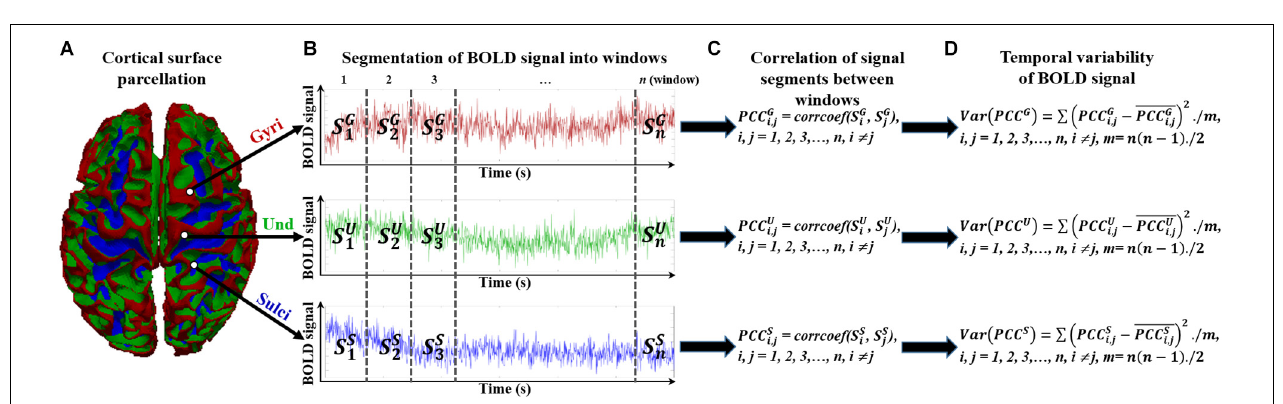
FIGURE 1 | Cortical surface parcellation of gyri, sulci, and undefined. (A) The parcellated cortical surface when the convexity threshold value q equals 10, 15, 20, 25, and 30, respectively. (B) The parcellated cortical surface when q equals 30 from another five different views.